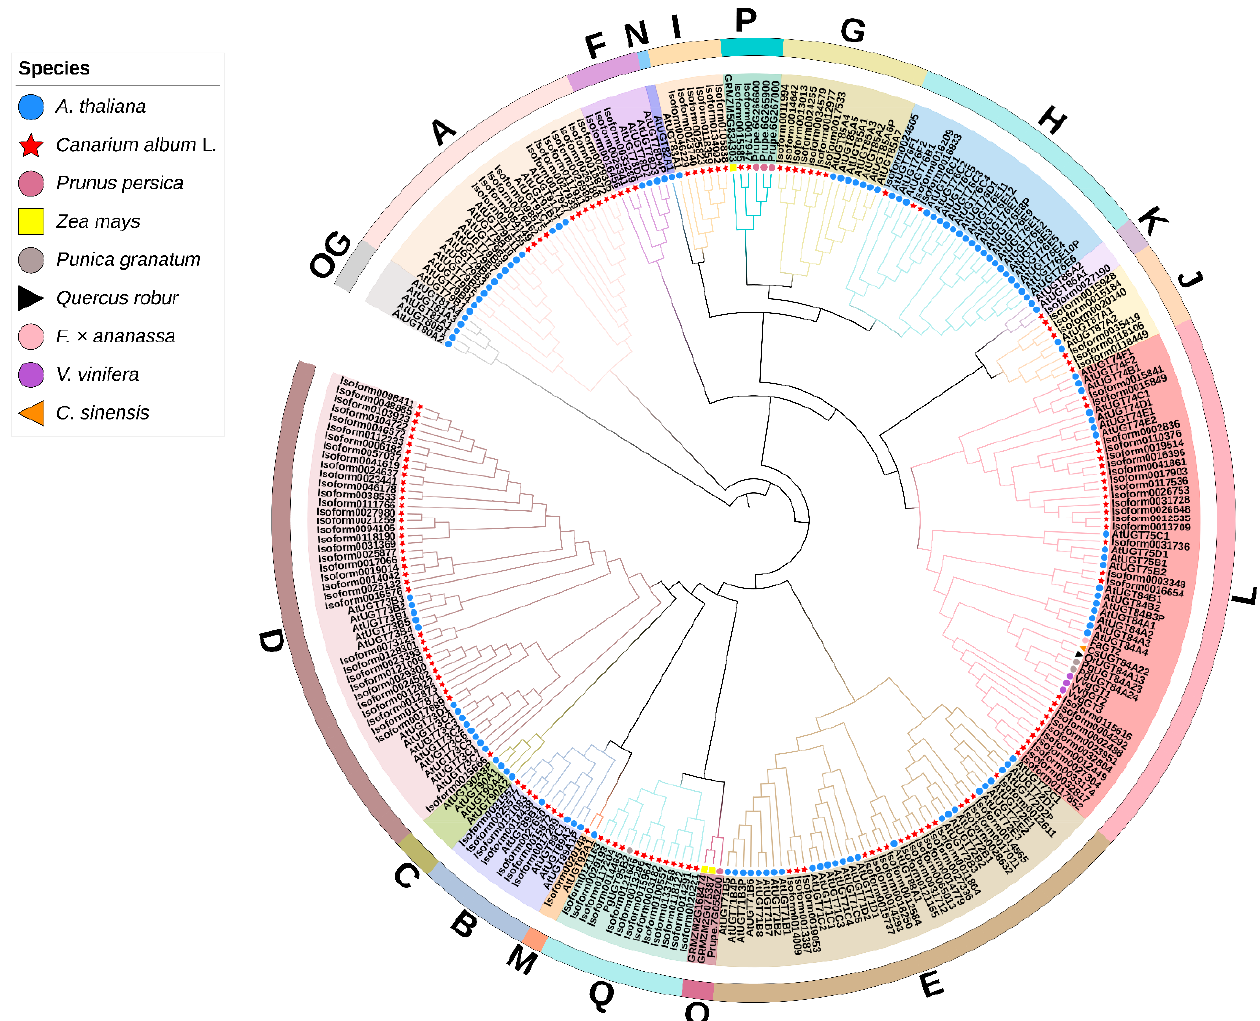
Figure 2. Phylogenetic analyses of C. album UDP-glucosyltransferase (UGT) family members. The phylogenetic tree was constructed in the MEGA 6.0 program using the Neighbour-Joining method, and the bootstrap value was set to 1000. A total of 278 amino acid sequences of different plant UGTs were used, including 140 C. album UGTs, 122 Arabidopsis UGTs, four Prunus UGTs, three Z. mays UGTs, one Punica UGT and eight other UGTs that have been functionally characterized, including UGTs from Punica granatum , Quercus robur , F. × ananassa , V. vinifera , and C. sinensis . The outermost letters indicate different groups, including groups A–Q and the OG. Their information was shown in Table S1. Each group is highlighted in a different color.